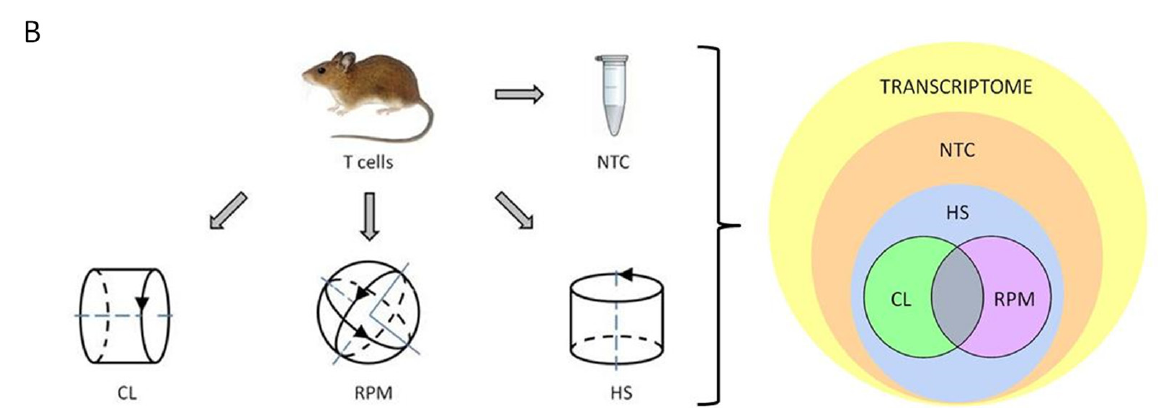
Figure 1. The principle and settings of experiment. ( A ) The principle of simulated microgravity experiments performed with mouse primary T cells (thymocytes) and human T cell culture (Jurkat) samples. Fast rotating clinostat (CL) and random positioning machine (RPM) used as simulated microgravity platforms. When rotating at sufficient speed, the suspension culture cells will be distributed homogeneously because the directional response to gravity is cancelled out. The cells rotate about themselves in simulated microgravity around one axis in CL and move randomly around two axes in RPM. Orbital shaker used as a hydrodynamic cell stress-inducing platform (HS). Direction of platform rotation is indicated by black arrows. Cell suspension sample movement illustrated by exemplary single cell trajectory shown in red. ( B ) The overview chart of experiment settings and output of RNA-seq transcriptome data analysis . Cell suspension of isolated primary mouse thymocytes (mouse T cells) was split into four parts, with each part treated as indicated. All four parts were processed for RNA isolation and generation of RNA library followed by RNA sequencing. The output sequencing results showed that most of RNA transcripts of mouse T cell transcriptome were detected in SMG-treated samples as well as in non-treated control (NTC) sample. Mouse T cell transcriptome response to microgravity in each of the used experimental platforms -clinostat (CL) and random positioning machine (RPM) develops in parallel with and mainly on a transcriptional background of T cell response to hydrodynamic stress (HS). The transcripts overlapping between CL and RPM panels were considered to represent gene candidates of the specific mouse T cell transcriptome response to simulated microgravity.